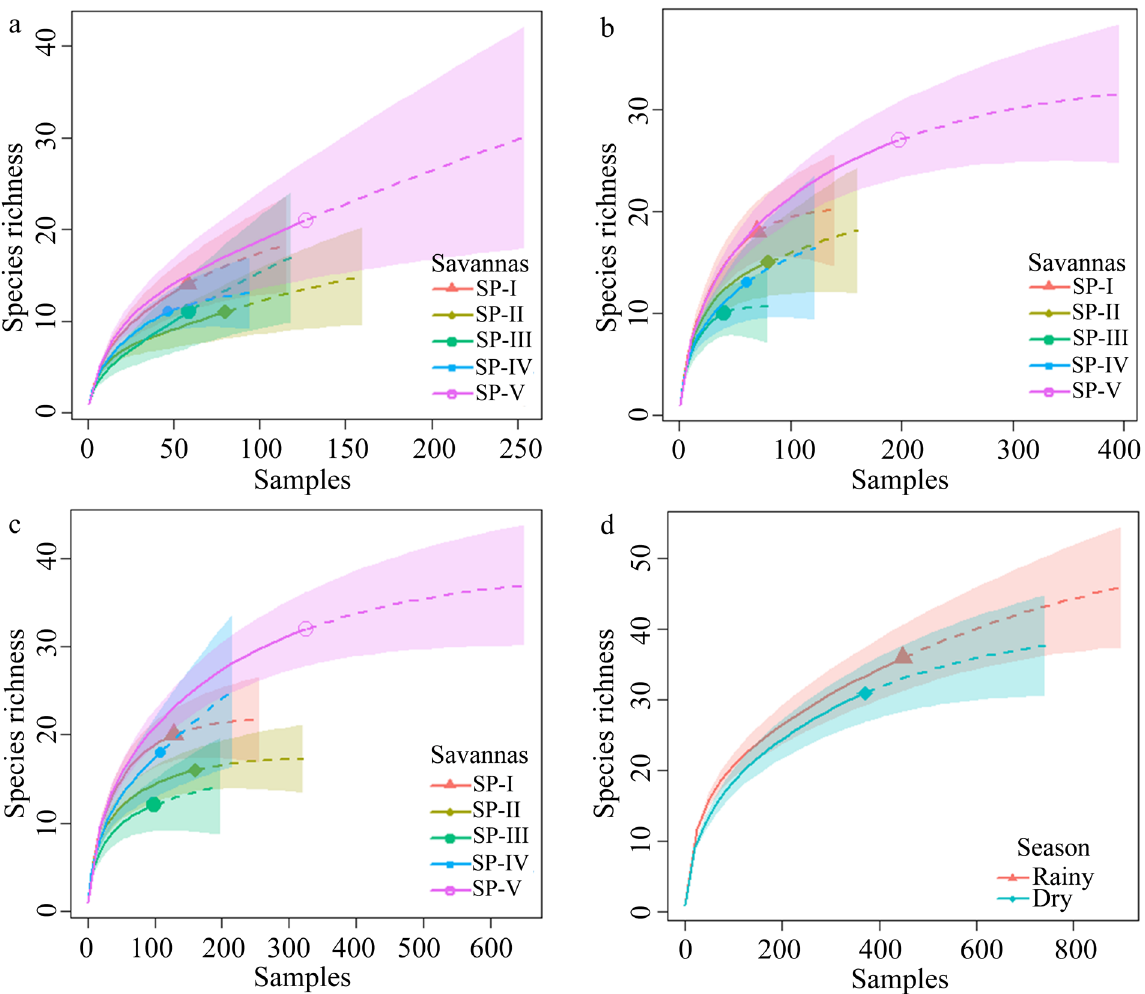
Figure 1. Species accumulation curves in the sampled Park Savanna areas and seasons, Marajó Island, Pará. (a) all areas per dry season; (b) all areas per rainy season; (c) all areas; (d) all areas per rainy and dry